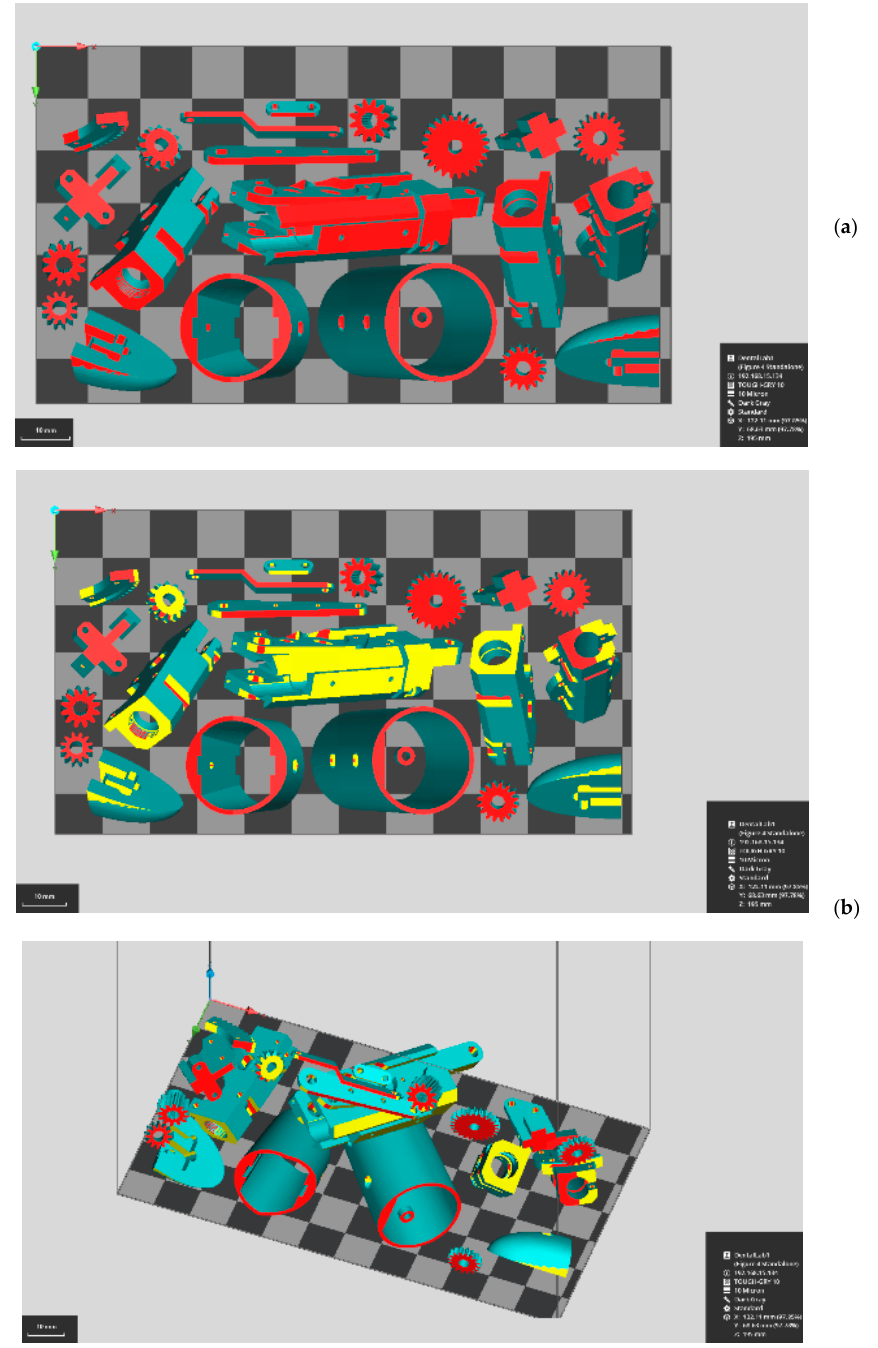
Figure 20. The downface verification based on angle and slope. ( a ) Downface of 45°, ( b ) downface of 35°.